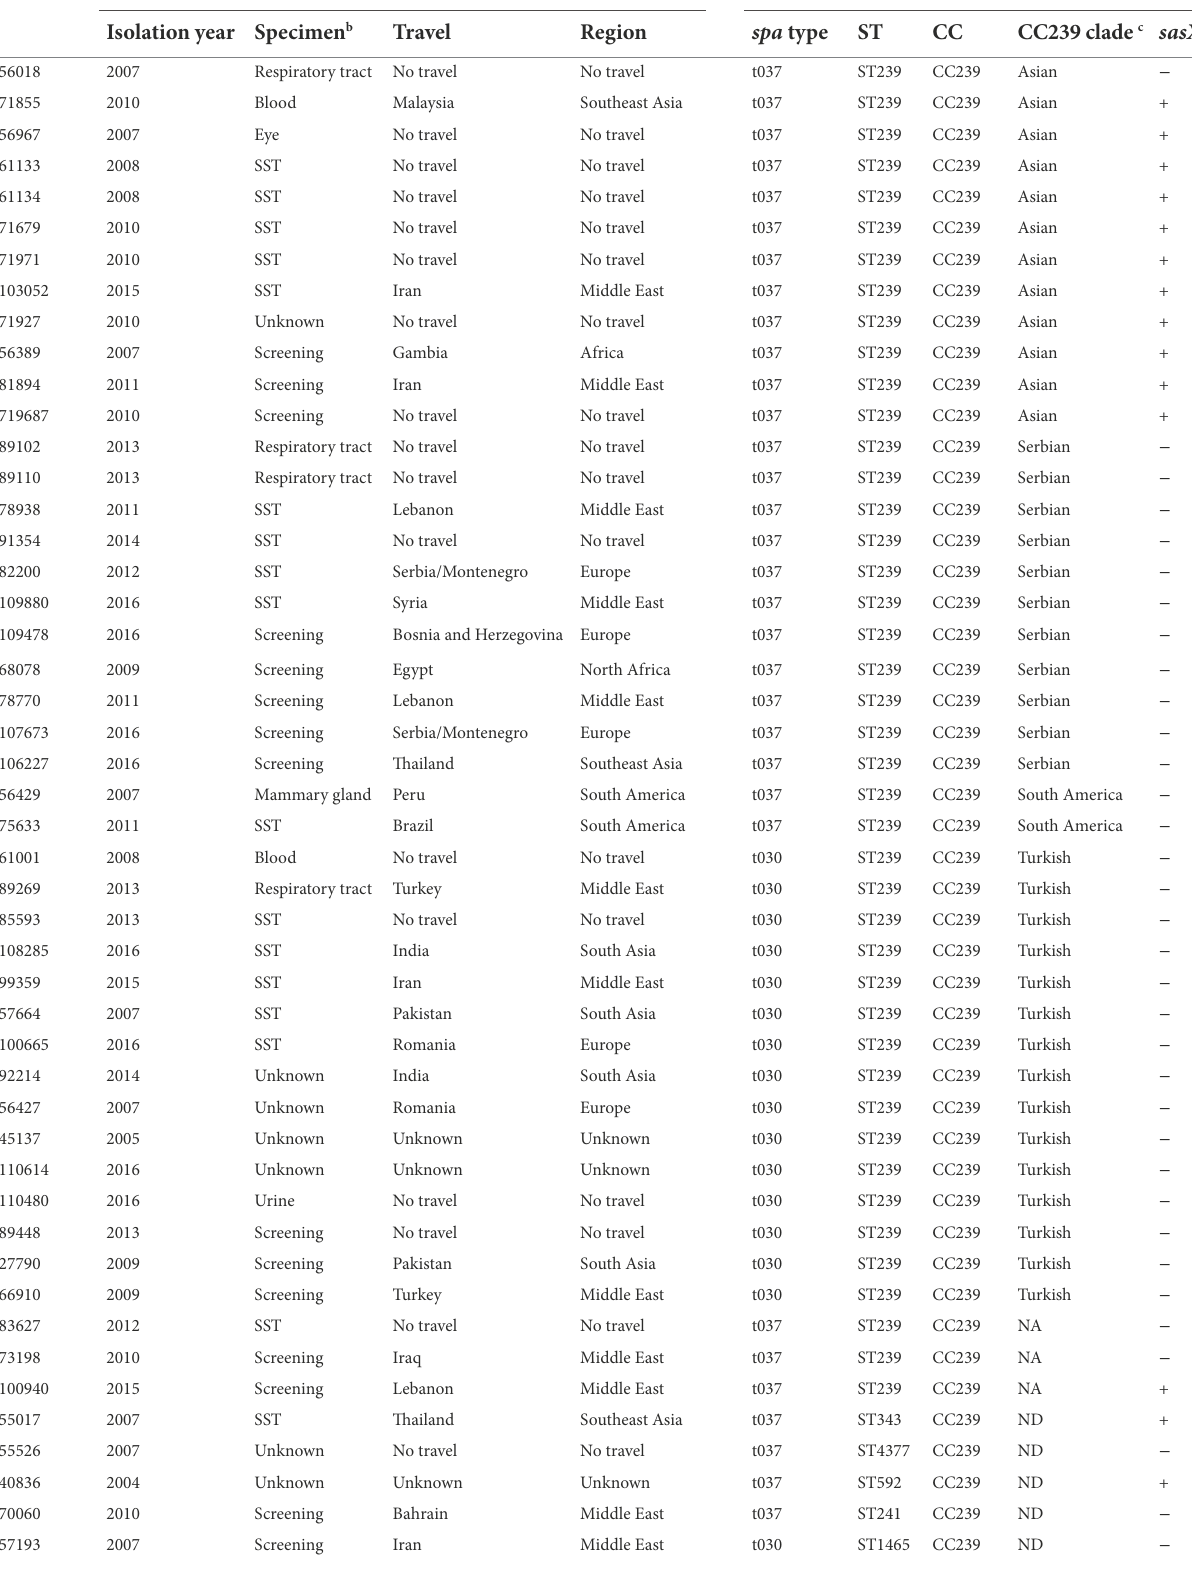
TABLE 1 Clinical information and characteristics of isolates used in this